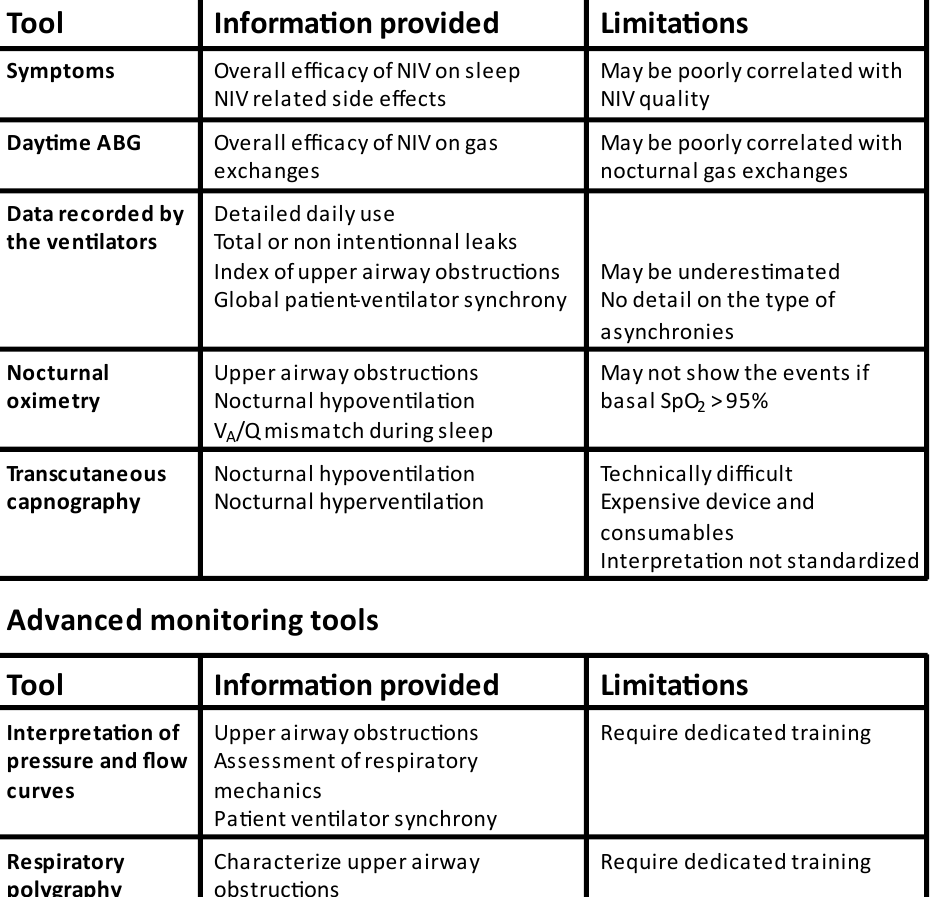
Figure 11. Strategy to monitor NIV. The basic monitoring package is recommended for all patients while advanced monitoring tools are only required in selected patients.